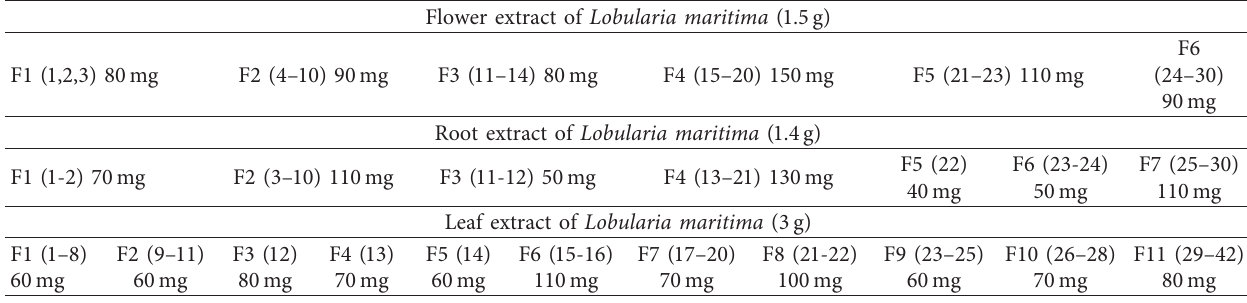
Table 4: Schematic view of the fractioning result of flower, root, and leaf extracts of Lobularia maritima . Flower extract of Lobularia maritima (1.5g)